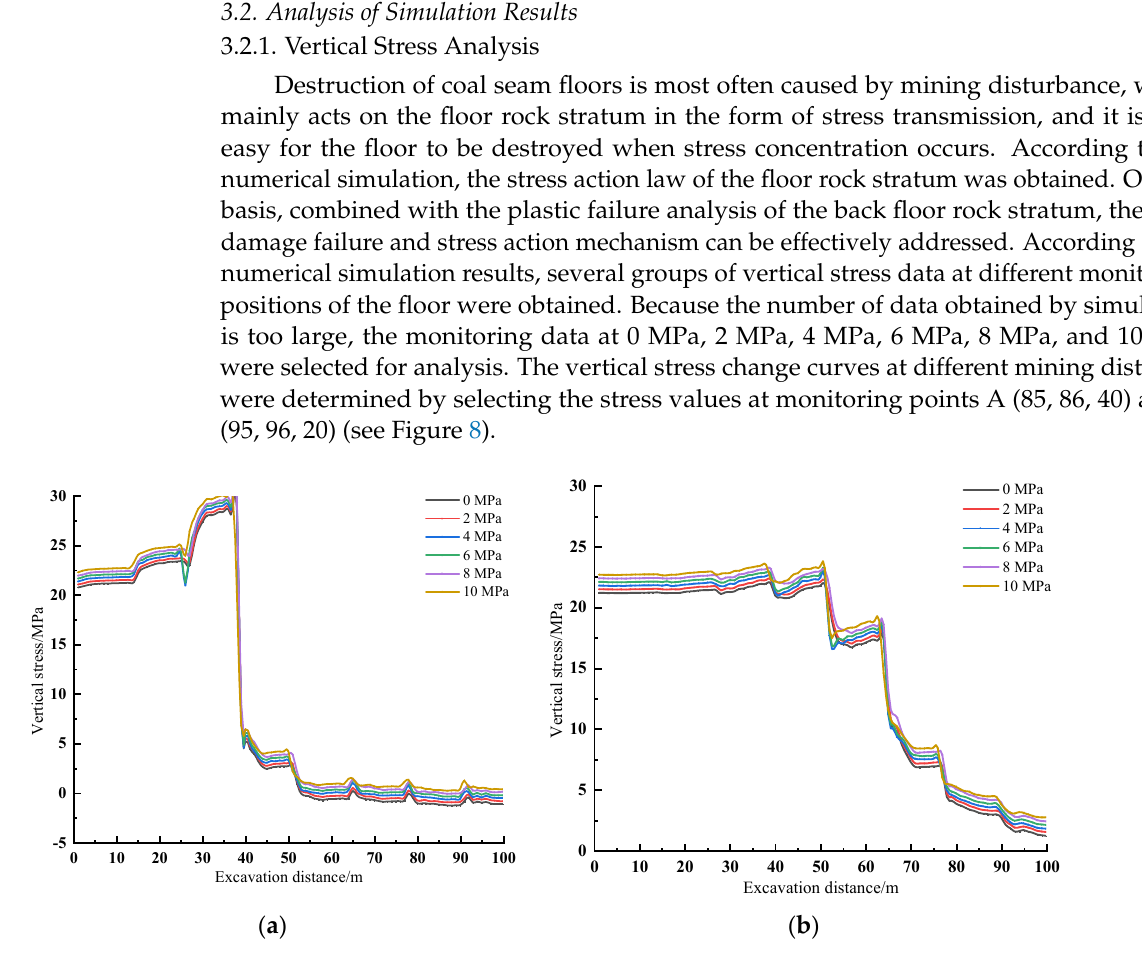
Figure 8. Vertical stress curves of monitoring points under different water pressures. ( a ) Monitoring point A, ( b ) monitoring point B.